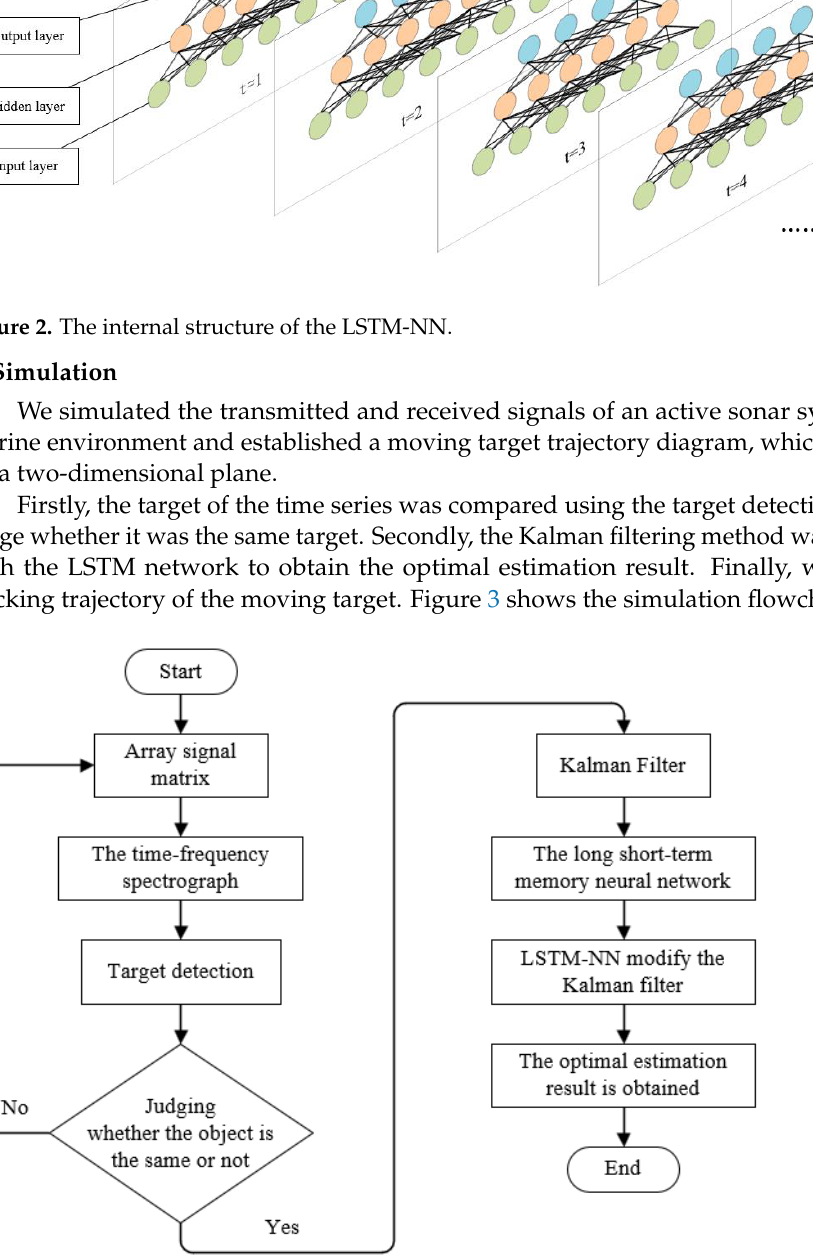
Figure 3. The simulation flowchart of the LSTM–Kalman filtering method.